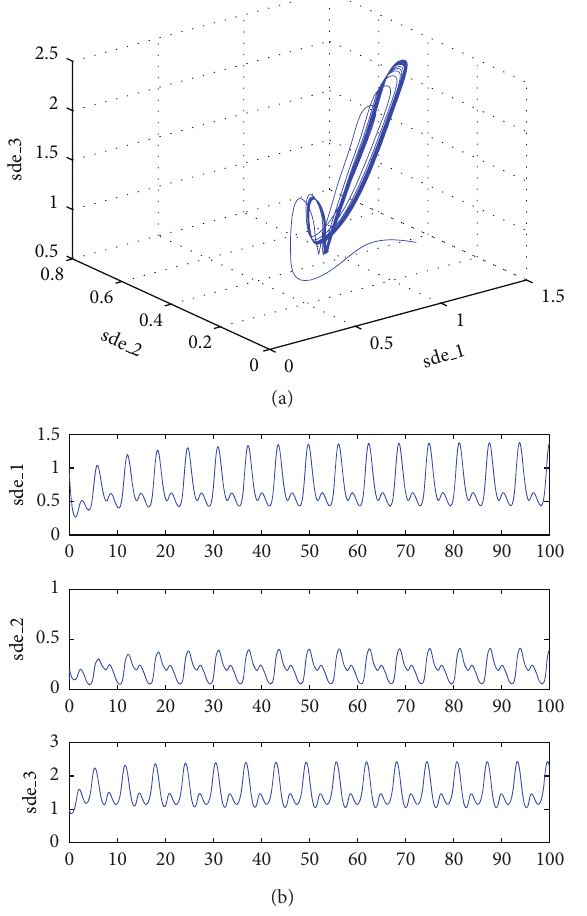
Figure 18: Deterministic system with a white noise 𝑢 𝑖𝑖 = 0 , 𝑖 = 1, 2, 3